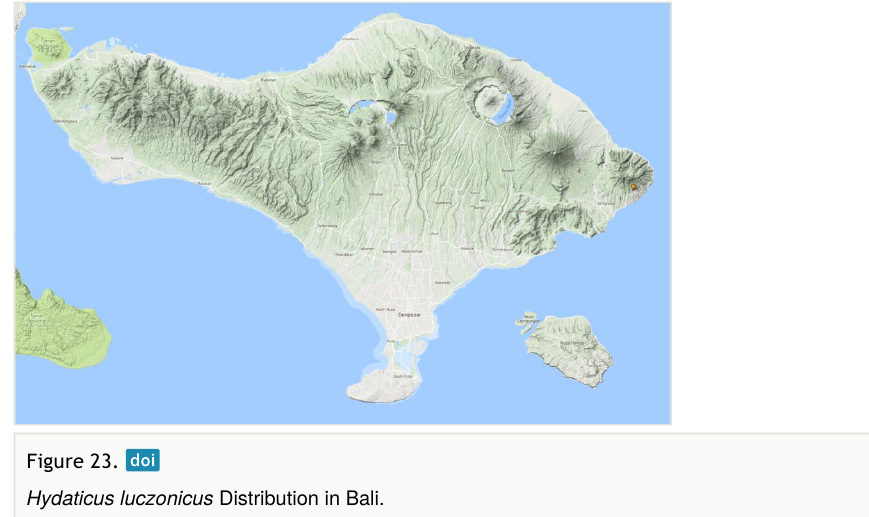
Figure 23. Hydaticus luczonicus Distribution in Bali.